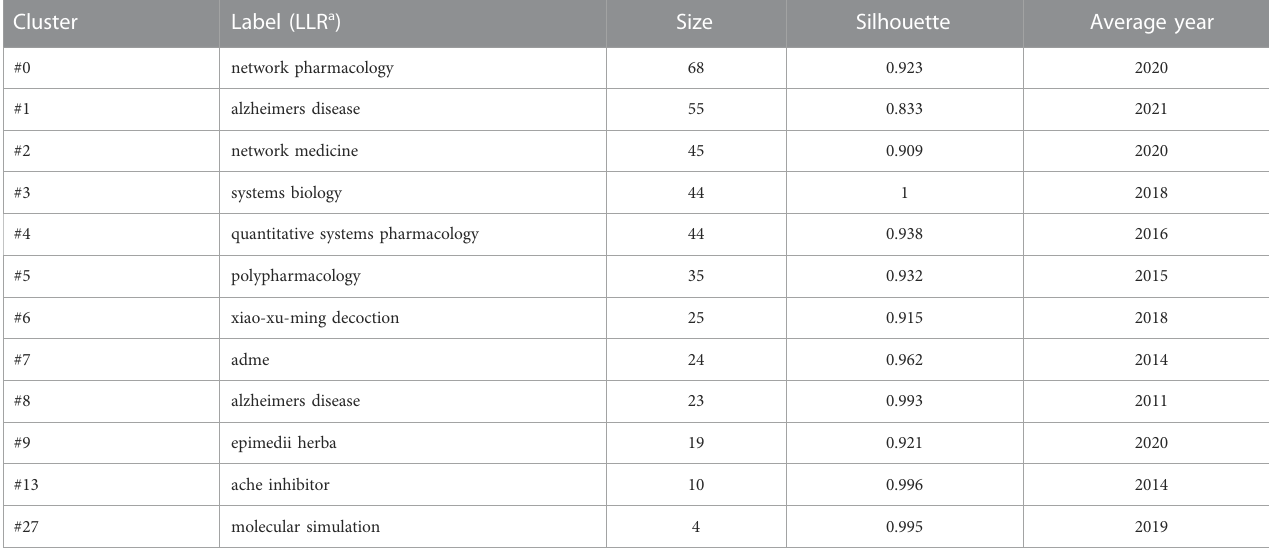
TABLE 6 Top 12 largest clusters of co-cited references.